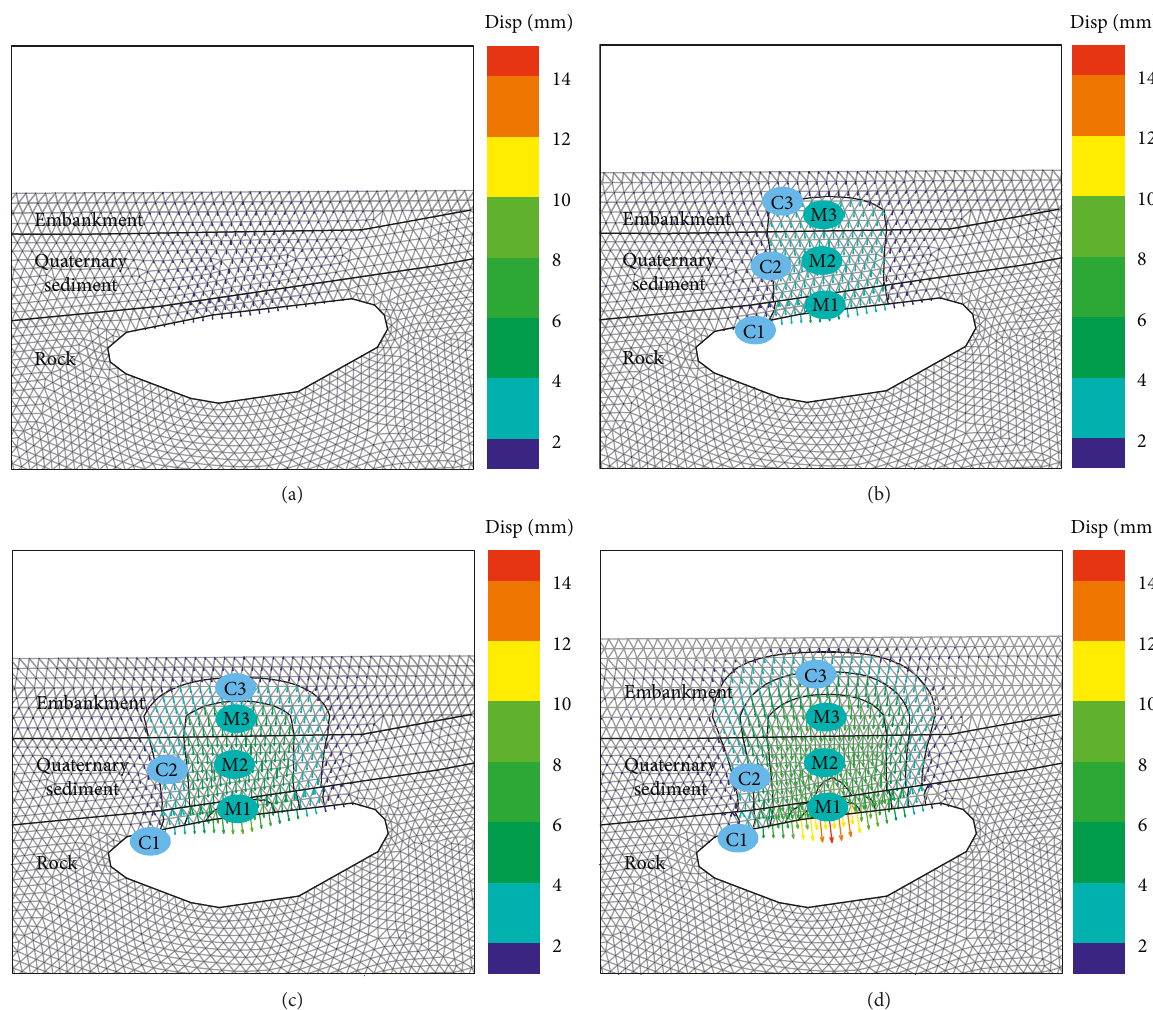
Figure 22: Evolution of the bedrock sagging sinkhole during the embankment construction. (a) Stage 1. (b) Stage 2. (c) Stage 3. (d) Stage 4.